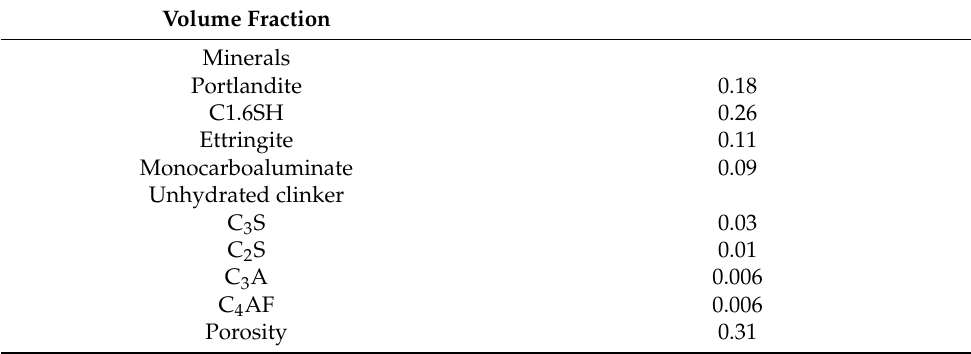
Table 3. Calculated total porosity from minerals and unhydrated clinker volume